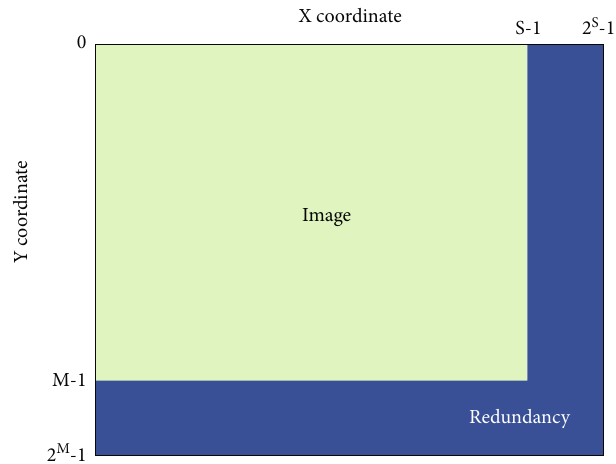
Figure 7: E ff ective color pixel and redundant color pixel map processed by the algorithm model.